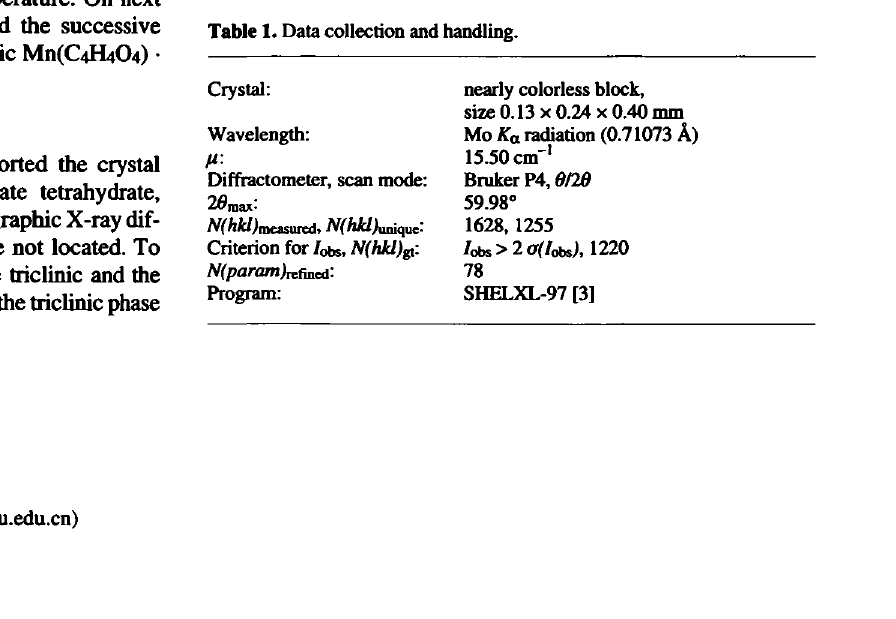
Table 1. Data collection and